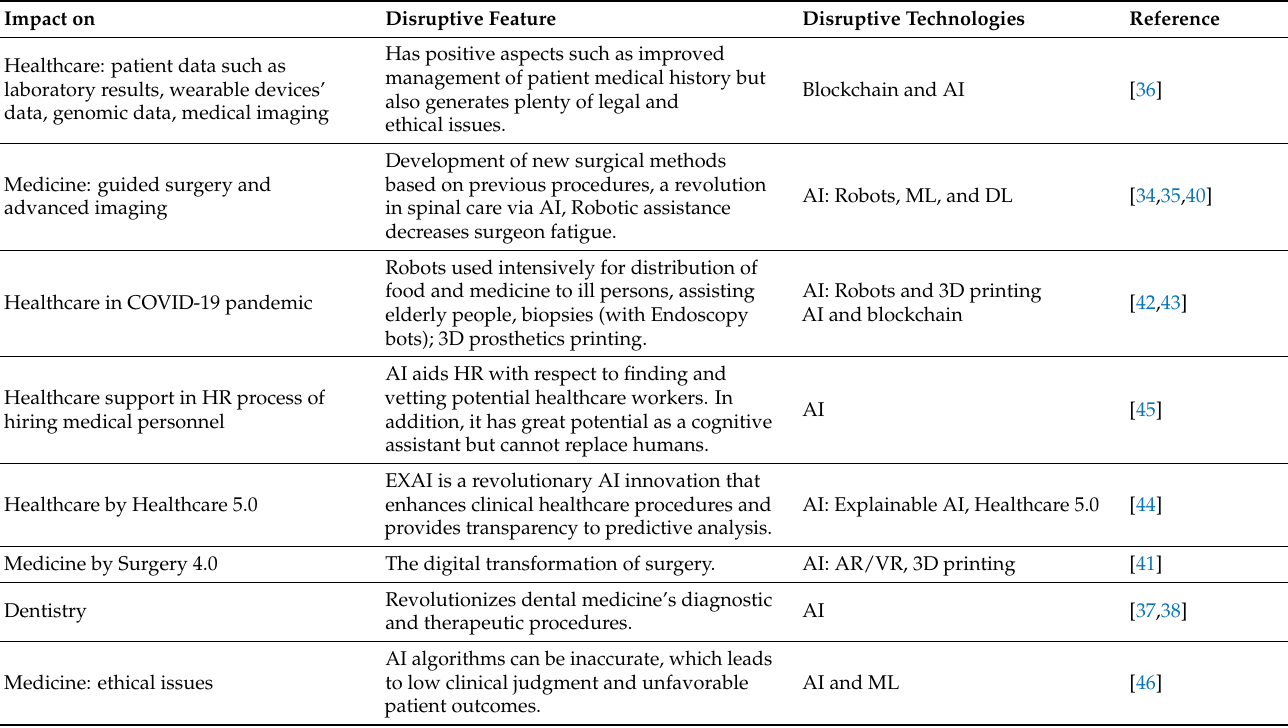
Table 4. Disruptive use of AI in healthcare and